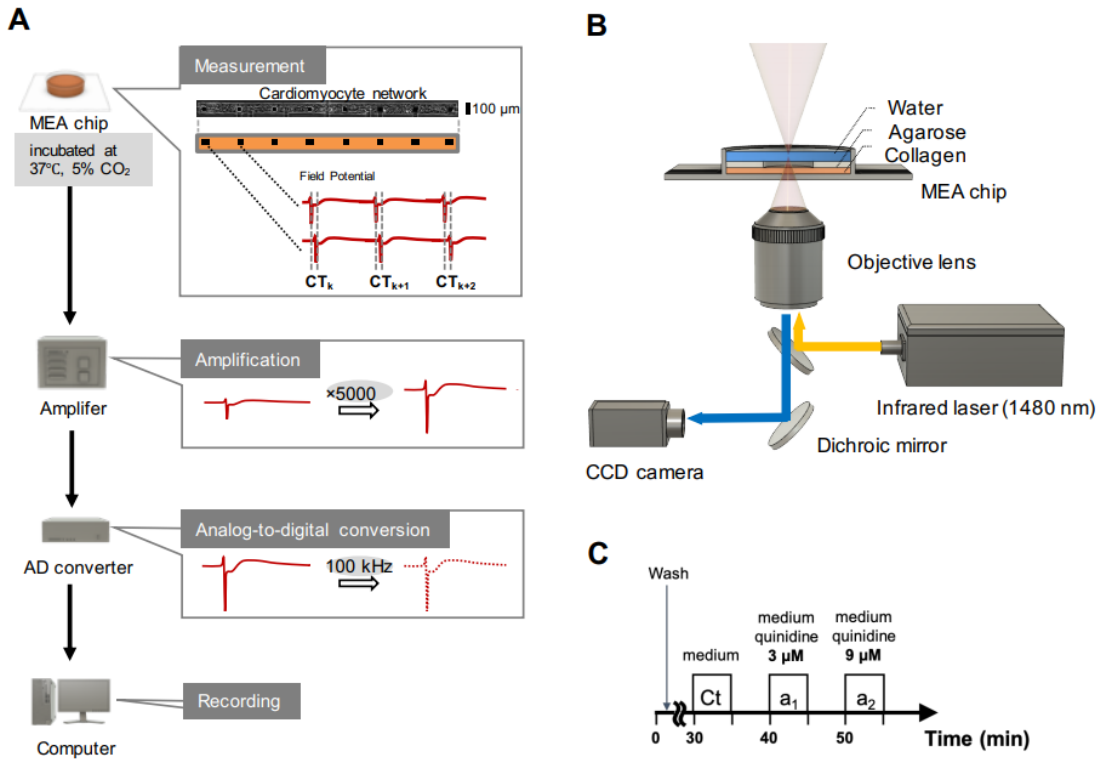
Figure 1. Conduction time measurement system setup and method. ( A ) Schematic drawing of multi-electrode array measurement system. Cardiomyocyte networks were cultivated in the rectangular-shaped agarose microstructures on the multi-electrode array (MEA) chip. The external field potentials (FPs) of cardiomyocytes on microelectrodes were amplified and digitally recorded to calculate the conduction time. ( B ) Setup of optical light pathways of the system. For the preparation of linearly craved MEA chip with collagen coating, a 1480-nm infrared laser beam was focused on the agarose layer of the MEA chip with x10 objective lens for spot heating of a portion of agarose layer for forming the microstructures. Phase-contrast images of cells in the microchambers were also recorded by the charge-coupled device (CCD) camera. ( C ) Time-course of drug administration. FP waveforms were recorded during 5 min of drug exposure in control medium (Ct), low concentration Quinidine (a1), and high concentration of Quinidine (a2).